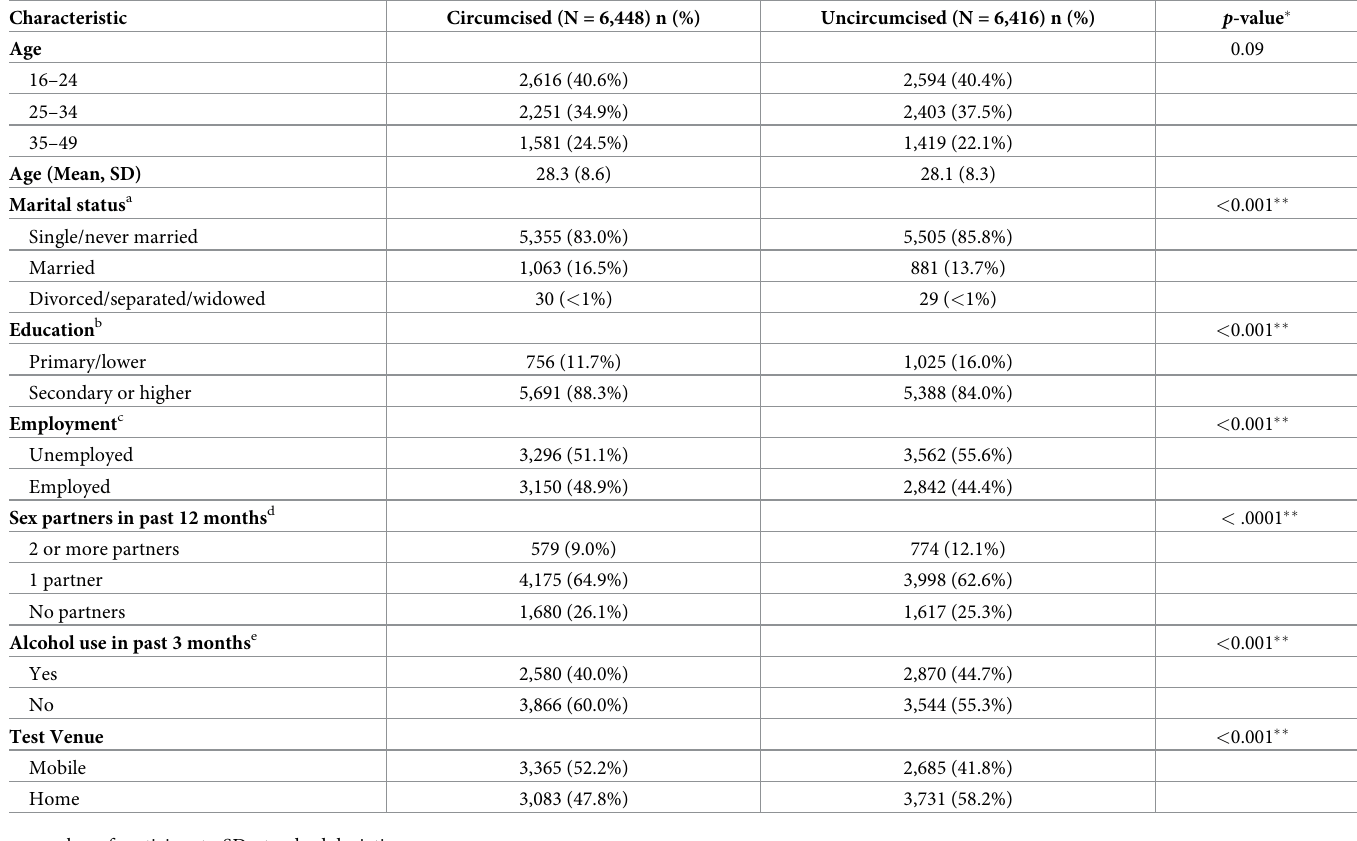
Table 1. Characteristics of men aged 16–49 years circumcised vs. not circumcised at baseline, N =